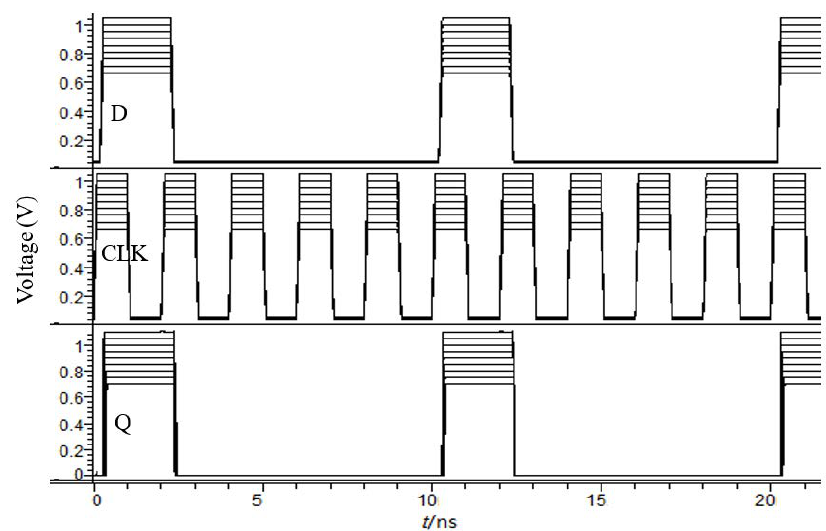
Figure 14. Design simulation under working voltages of 0.7–1.1 V.